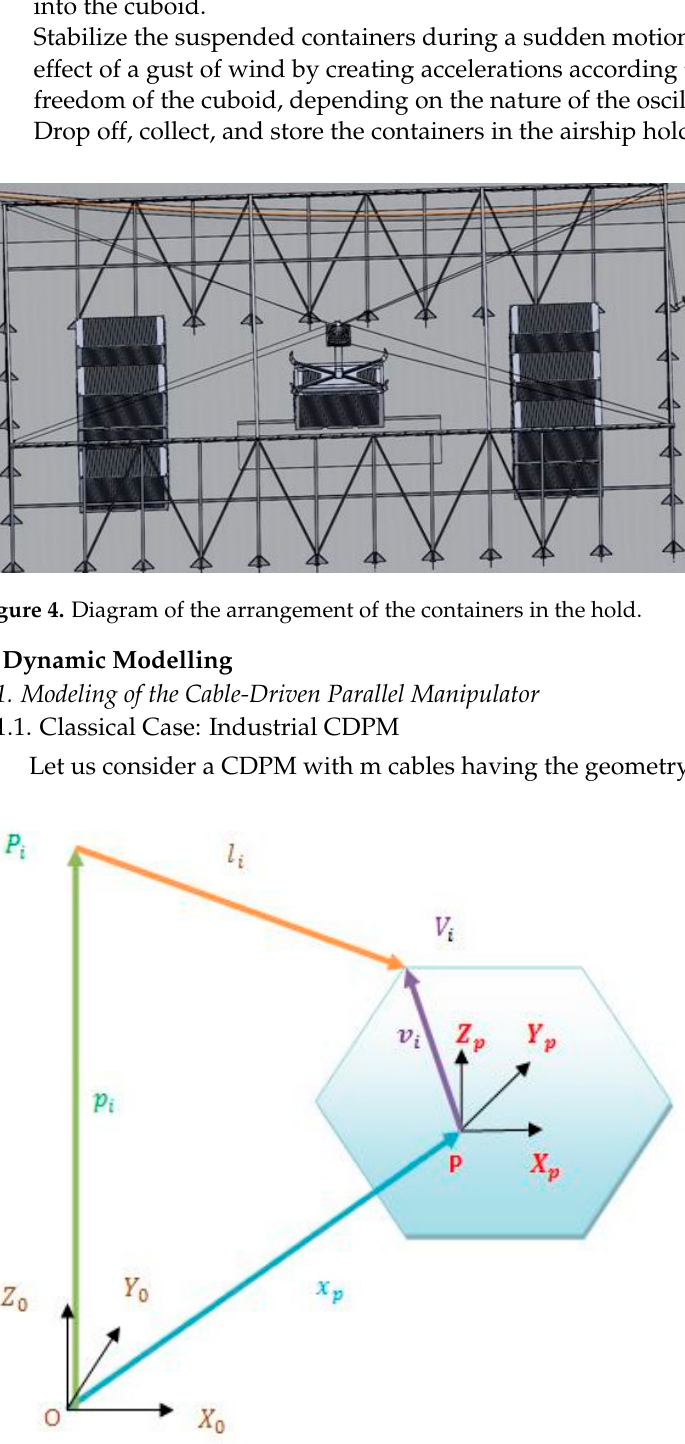
Figure 5. General Architecture of a CDPM.